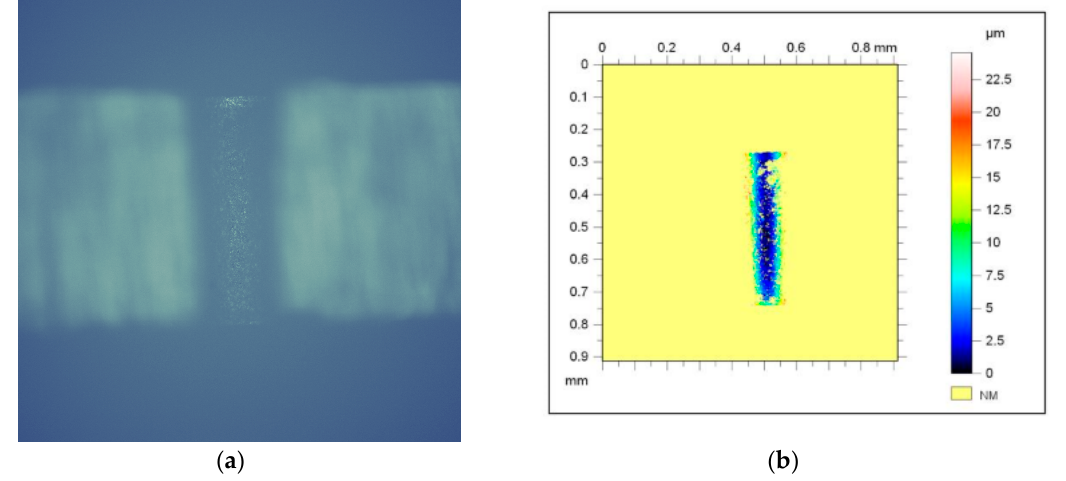
Figure 3. Surface roughness measurement using Talysurf CCI-6000, ( a ) Optical View; ( b ) Surface Roughness Analysis.